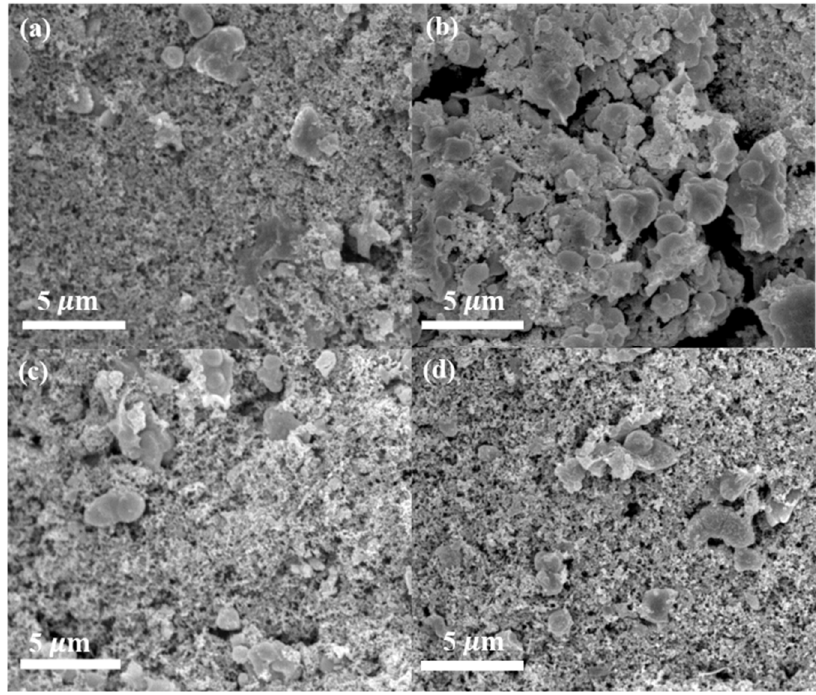
Figure 10. SEM images of the cathode before and after cycling. ( a ) NMCP cathode before cycling; ( b ) NMCP cathode after cycling; ( c ) NMCP/rGO cathode before cycling; ( d ) NMCP/rGO cathode after cycling.